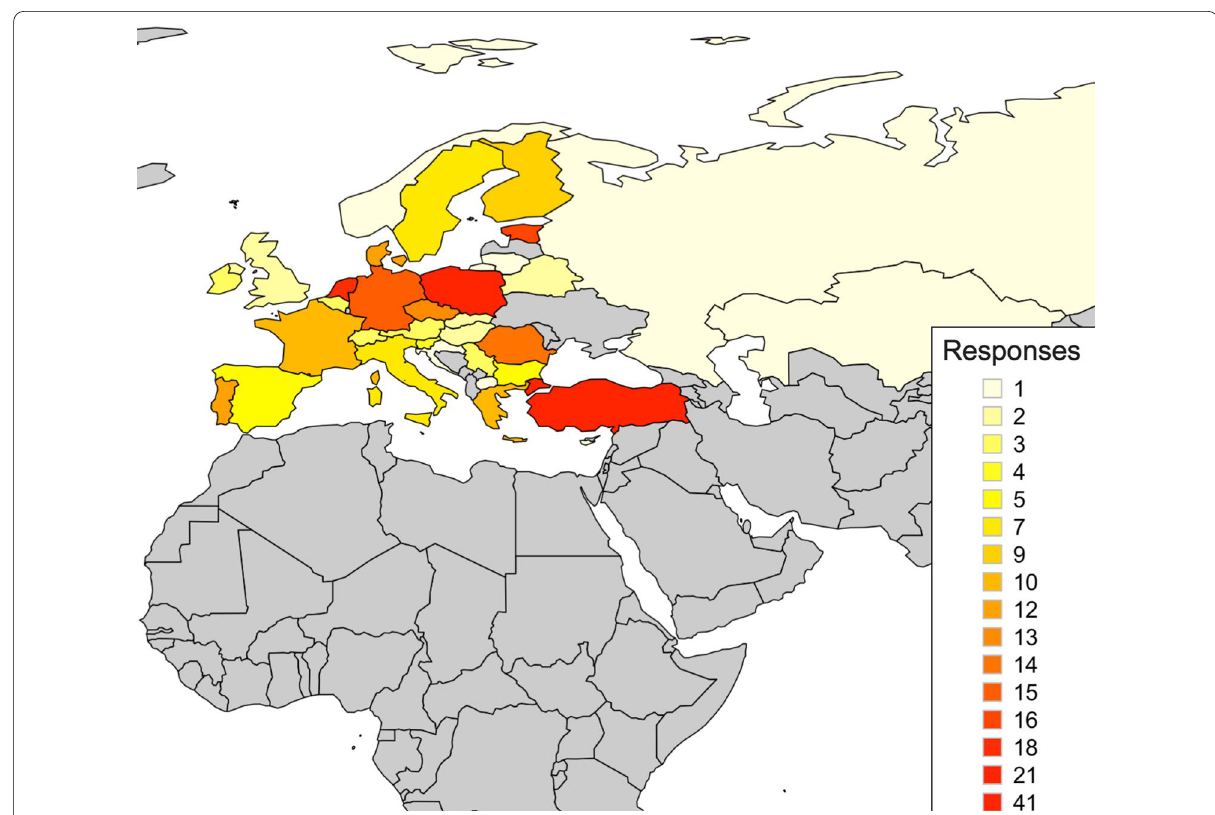
Fig. 2 Map depicting the number of responses collected from each country member of the European Society of Radiology